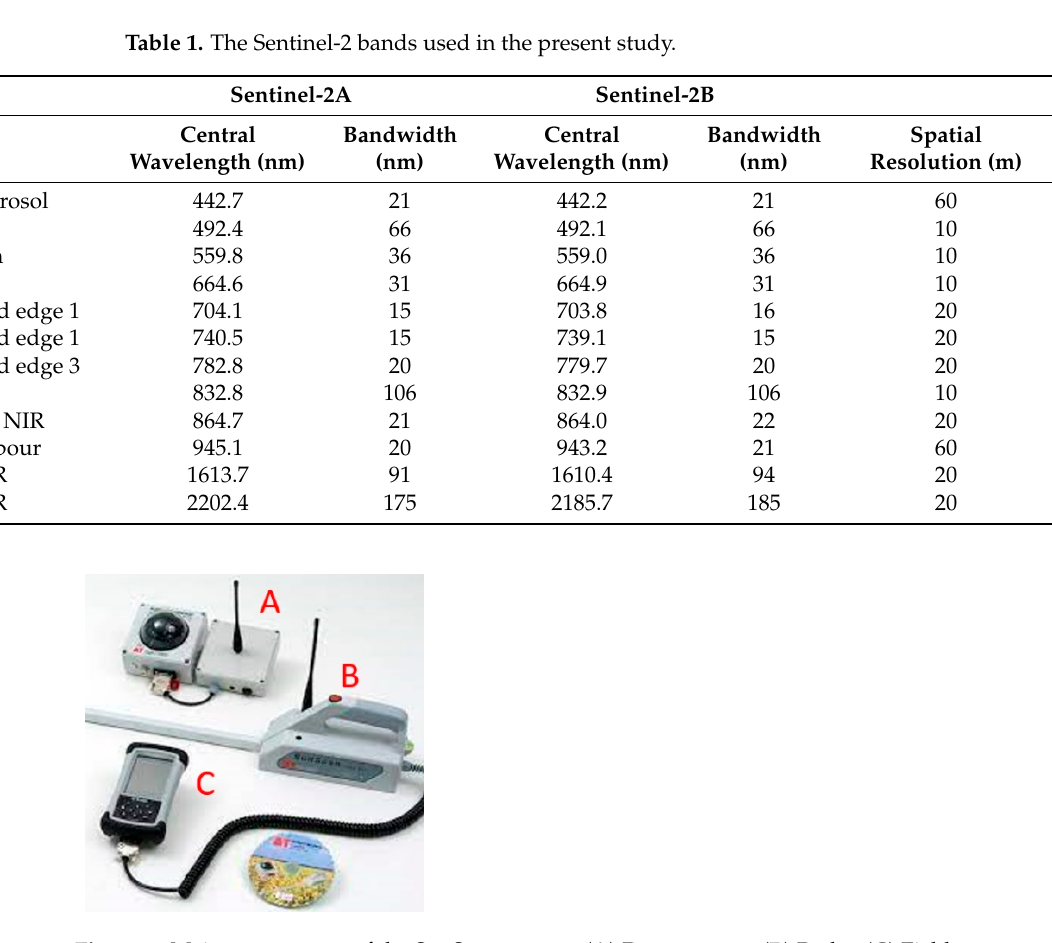
Figure 2. Main components of the SunScan system: ( A ) Dome sensor; ( B ) Probe; ( C ) Field computer.